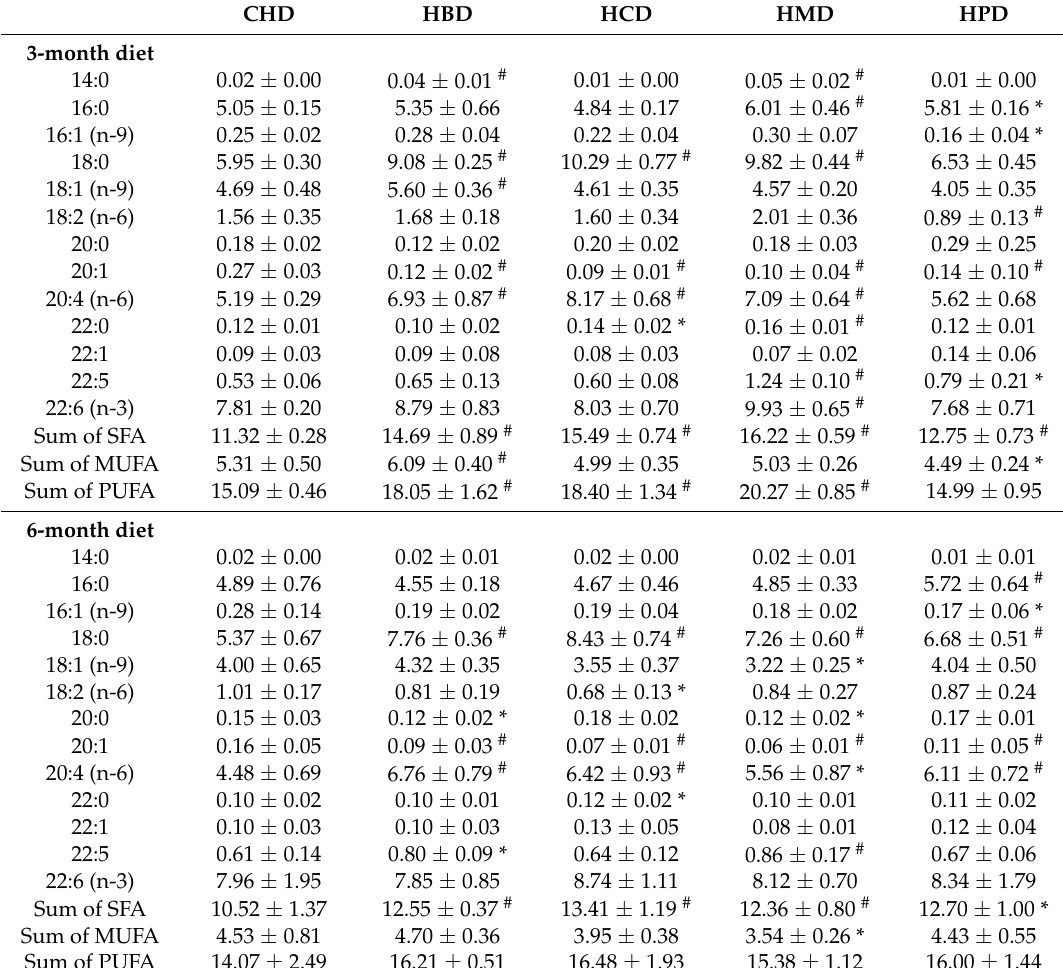
Table 3. Fatty acid profile of phospholipids in hearts of mice fed different high-fat